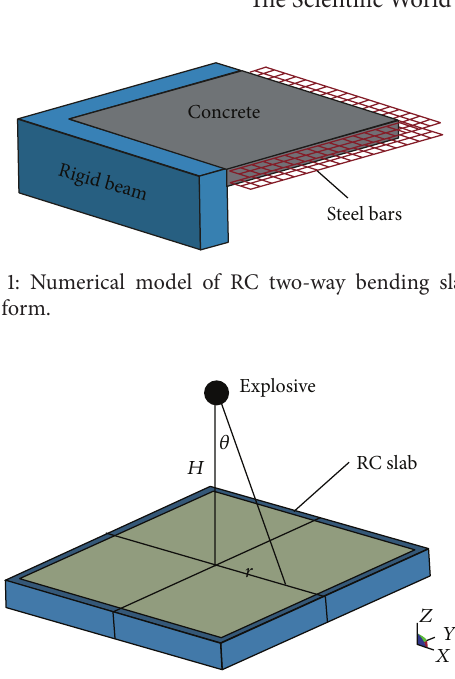
Figure 2: Calculating diagram of RC slab under